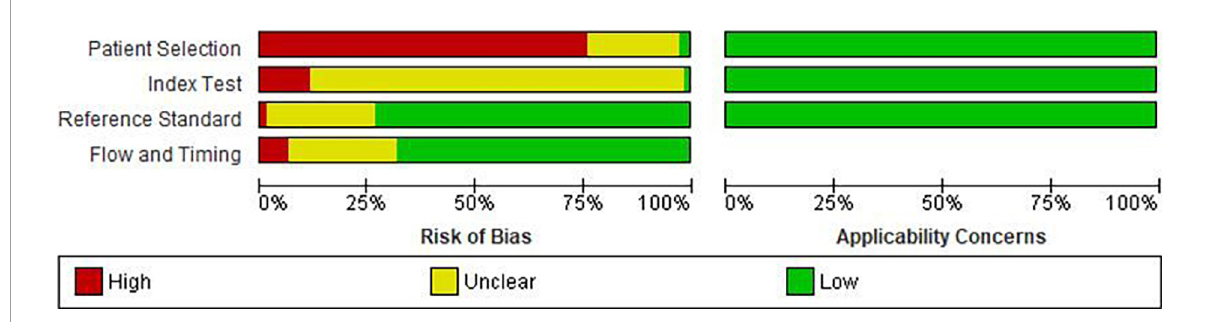
FIGURE3 Risk of bias in the included studies.